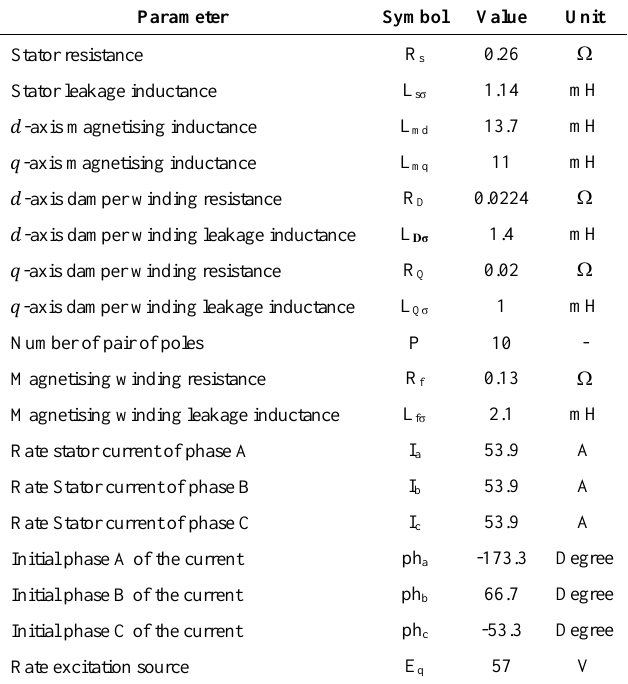
Table 3. The simulation parameters